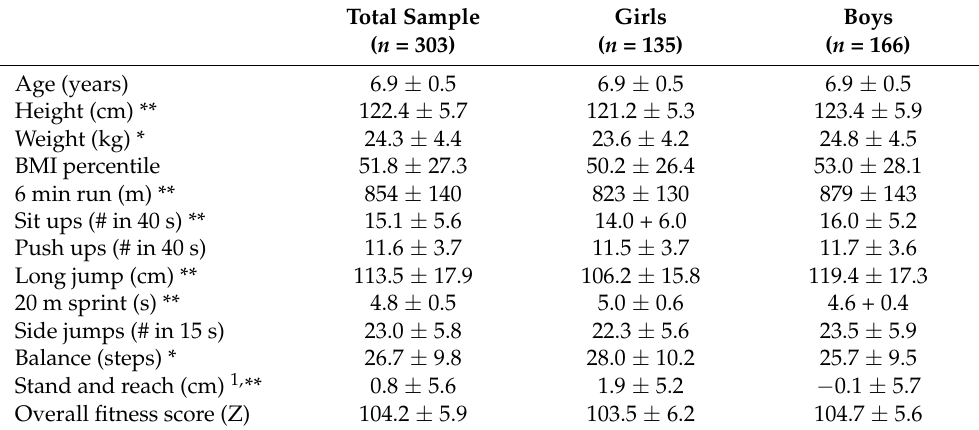
Table 1. Descriptive characteristics at baseline for the total sample and separately for boys and girls. Values are Mean ± SD. Total